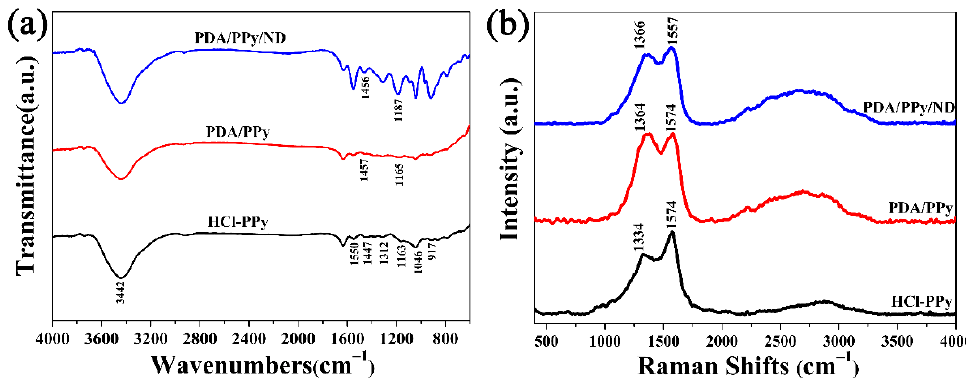
Figure 3. ( a ) FTIR spectra of HCl-Ppy, PDA/Ppy and PDA/Ppy/ND. ( b ) Raman spectra of HCl-Ppy, PDA/Ppy and PDA/Ppy/ND.